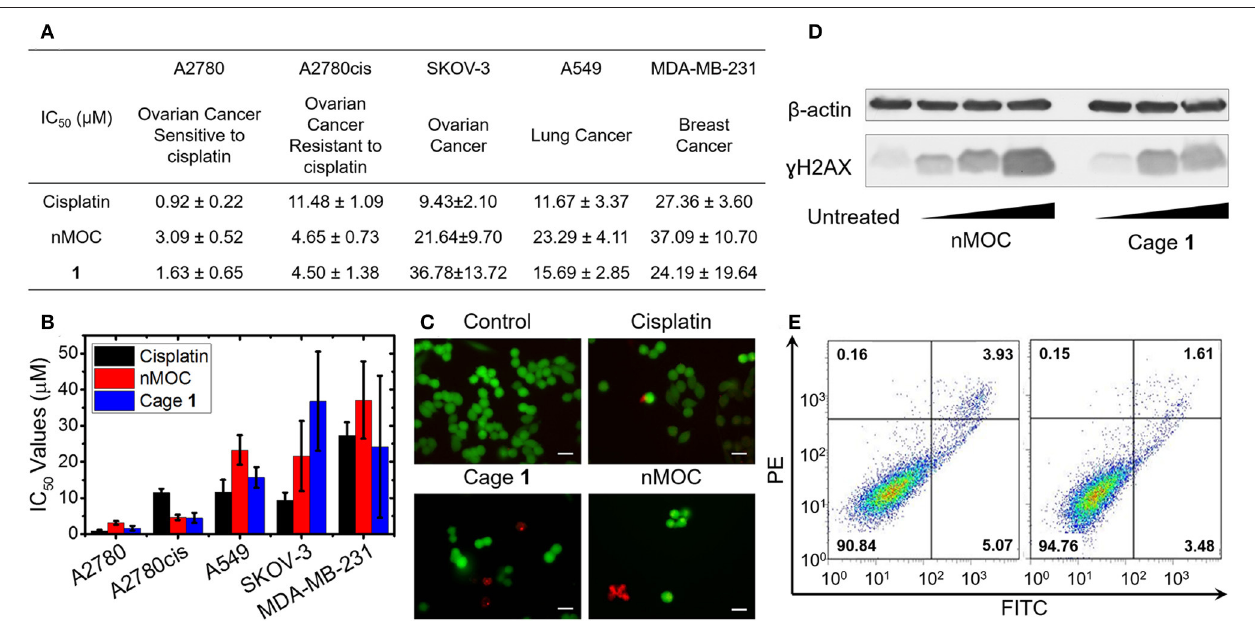
FIGURE 2 | Cellular responses of the metal-organic cage (1) and the nanoparticles of MOCs. (A) A table of the IC 50 values of cisplatin, 1 , and nMOC determined by MTT assays; (B) Bar graph of IC 50 values obtained using a panel of human cancer cell lines; (C) Fluorescence microscopic images obtained for the live/dead cell assay using A2780cis cells treated with cisplatin, 1 , or nMOC; (D) Immunoblotting analysis of γ H2AX in A2780cis cell line; (E) Annexin V apoptosis assay using A2780cis cells treated with nMOC (left) and cisplatin (right).